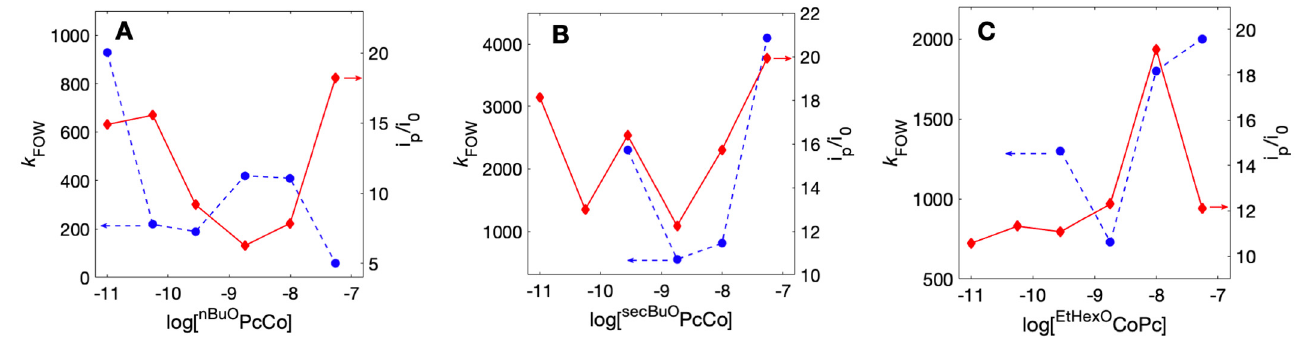
Figure 4. Comparisons of CO 2 reduction rate constants from FOW analysis (left x-axes) and the ratios of observed currents and maximum catalytic currents (i p /i 0 , right y-axes) for nBuO PcCo ( A ), secBuO PcCo ( B ), and EtHexO PcCo ( C ).